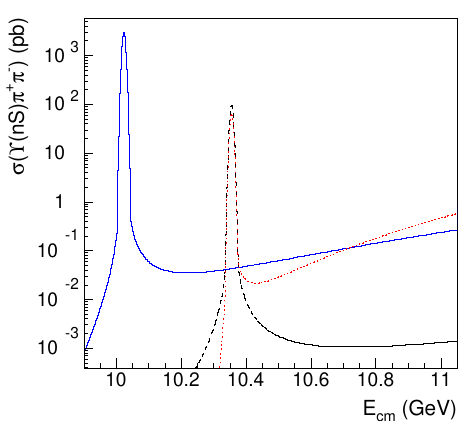
Figure 7 . Expected energy dependence of the cross sections for the processes e + e (cid:0) ! (cid:7)(2 S ) ! (cid:7)(1 S ) (cid:25) + (cid:25) (cid:0) (solid blue), e + e (cid:0) ! (cid:7)(3 S ) ! (cid:7)(1 S ) (cid:25) + (cid:25) (cid:0) (dashed black) and e + e (cid:0) ! (cid:7)(3 S ) ! (cid:7)(2 S ) (cid:25) + (cid:25) (cid:0) (dotted red). These include the c.m. energy spread of (cid:27) = 5 MeV.